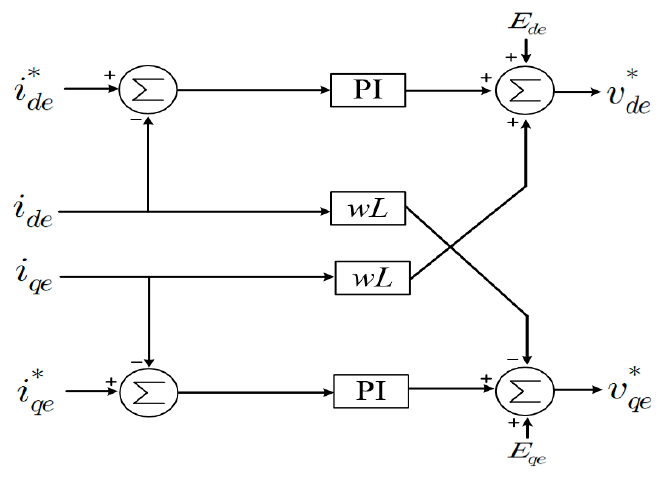
Figure 3. Control diagram of the current.